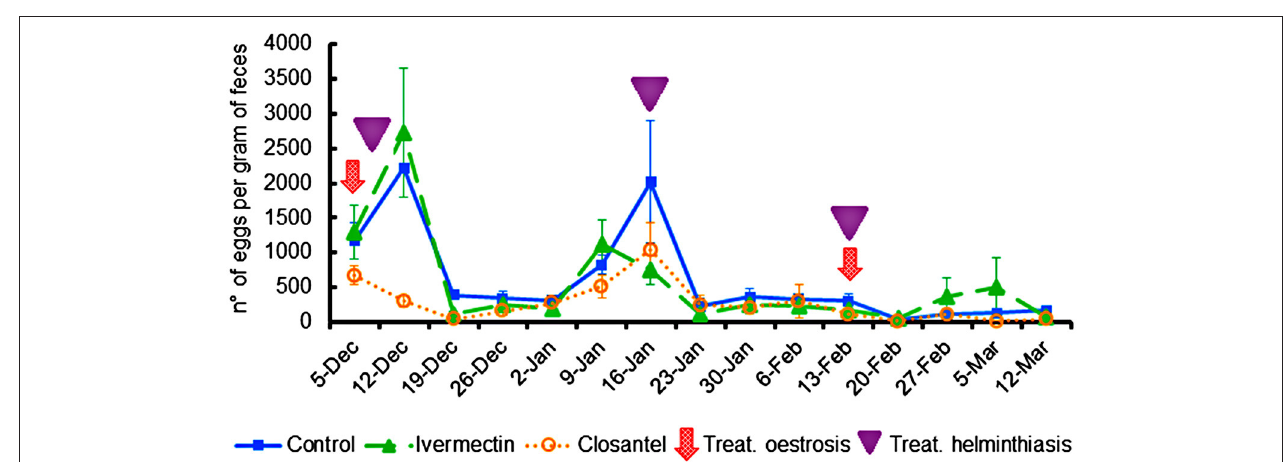
FIGURE 3 | Averages of eggs per gram feces ( ± standard error) of lambs naturally infected with gastrointestinal nematodes and infested with O. ovis . The moments of treatments against oestrosis (with ivermectin or closantel) are indicated by arrow and treatments against helminthiasis (with a combination of levamisole + albendazole + monepantel) are indicated by